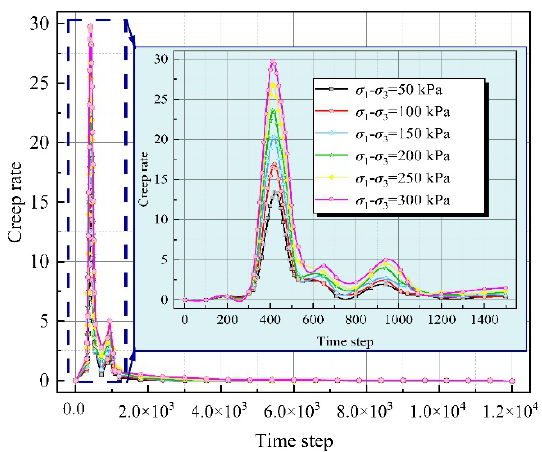
Figure 10. Variation of creep rate with time